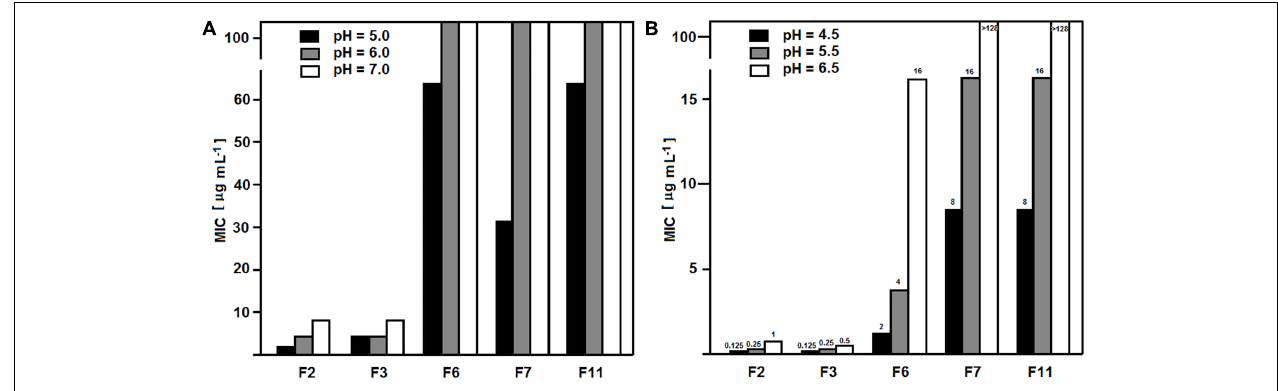
FIGURE 1 | pH dependence of MIC values of FMDP-oligopeptides. MICs were determined against C. albicans SC 5314. (A) RPMI-1640 buffered with MOPS. (B) YNB-SG buffered with MOPS.